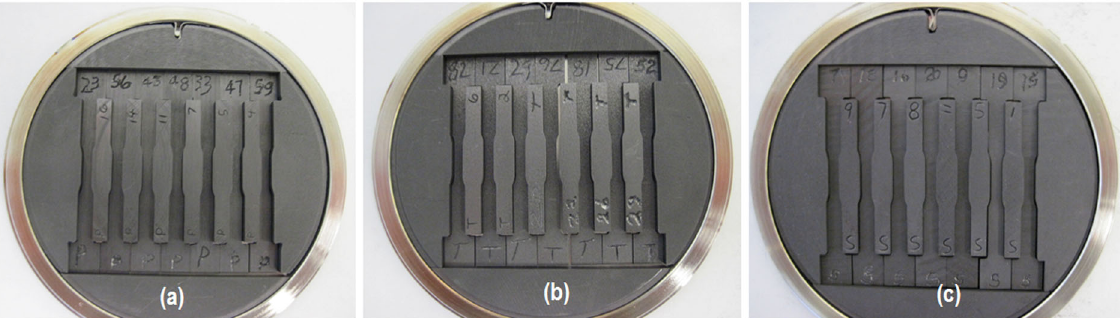
FIG. 3. Specimen layout within their respective argon-filled capsules of the LBNF graphite grades. (a) POCO, (b) IG 430, (c) SGL.